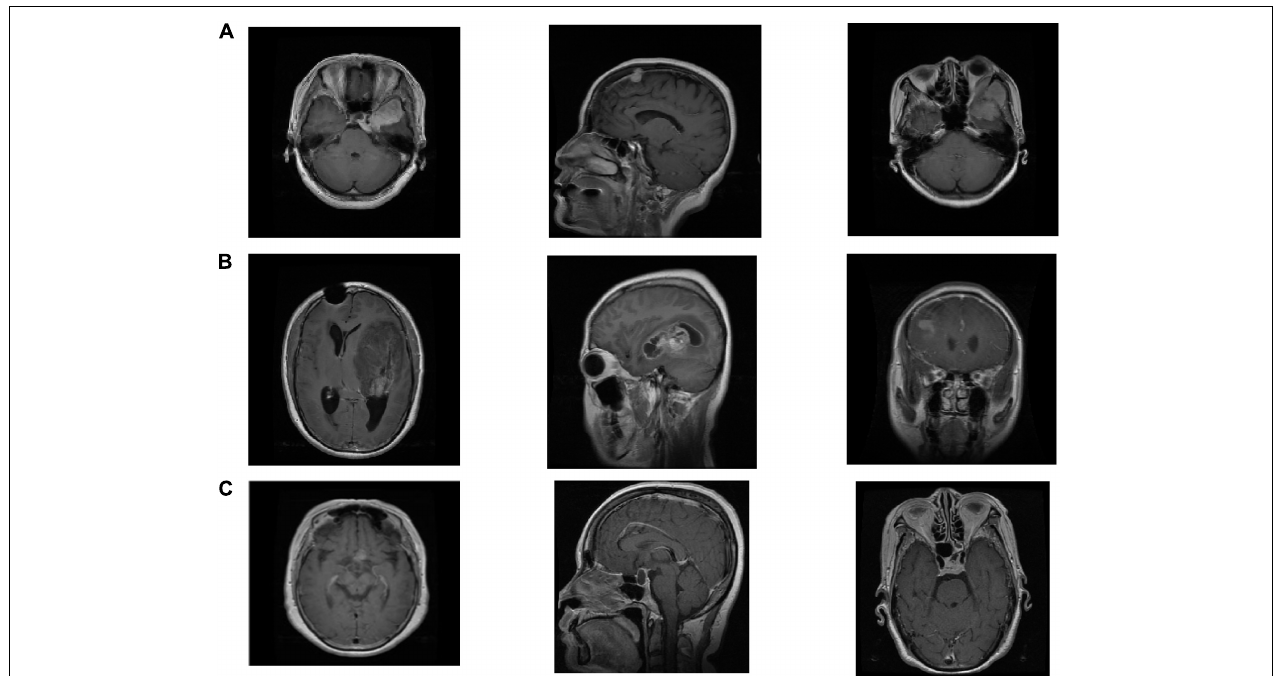
FIGURE 1 | The example samples in the Cheng dataset, (A) Meningioma, (B) Glioma, and (C) Pituitary.